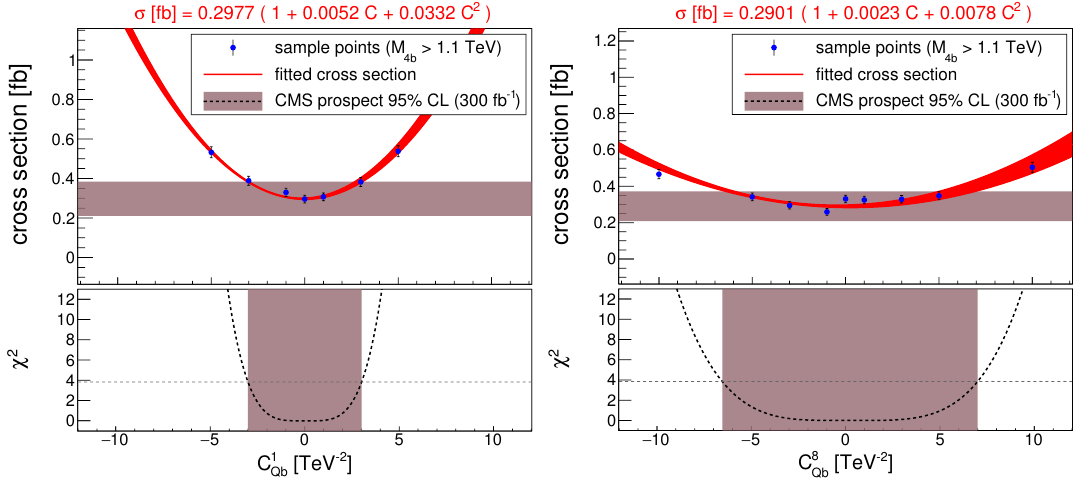
Figure 8 . Limits at 95% CL on C 1 assuming an integrated luminosity of 300 fb (cid:0) 1